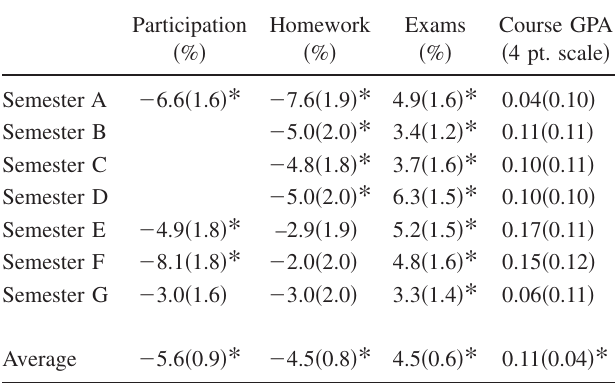
TABLE III. Analysis of students’ course grades. Each column contains the difference between the average scores for males and females (cid:1)(cid:5) S (cid:6) M − (cid:5) S (cid:6) F (cid:2) . Error (cid:1) shown in parentheses (cid:2) is computed from the standard errors of the mean for males and females added in quadrature. The asterisk (cid:1) * (cid:2) indicates that the difference is statisti- cally significant at the p (cid:3) 0.05 level.